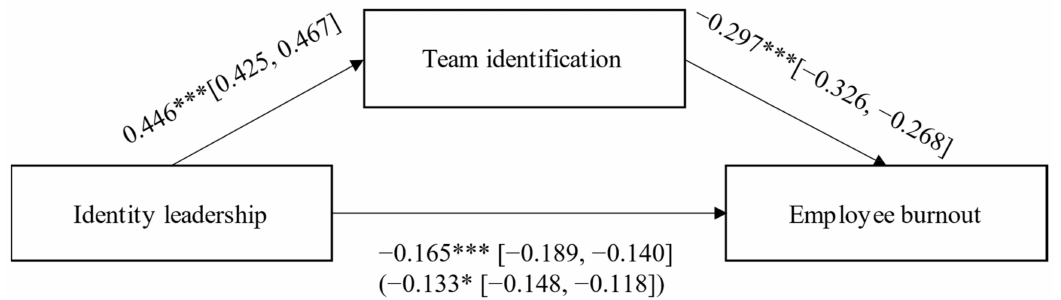
Figure 1. Mediation model with direct effects and the indirect effect (in parentheses) for full 2020/2021 sample. Note: * p < 0.05; *** p <